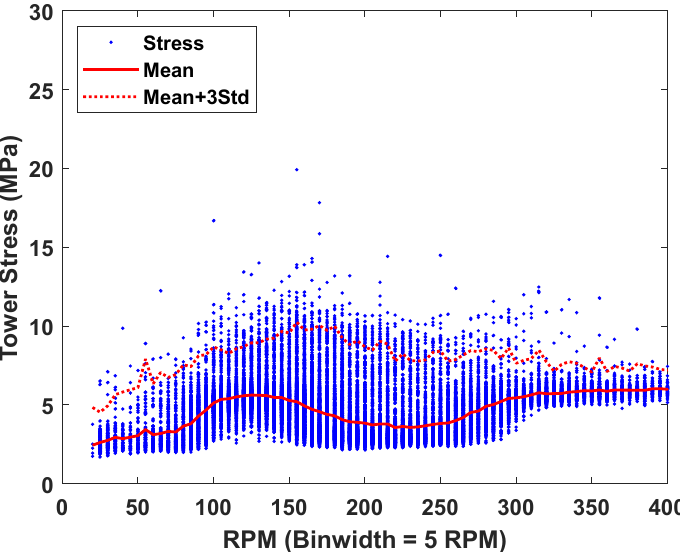
Figure 12. Maximum bending stress of the tower for each 1-minute data set.